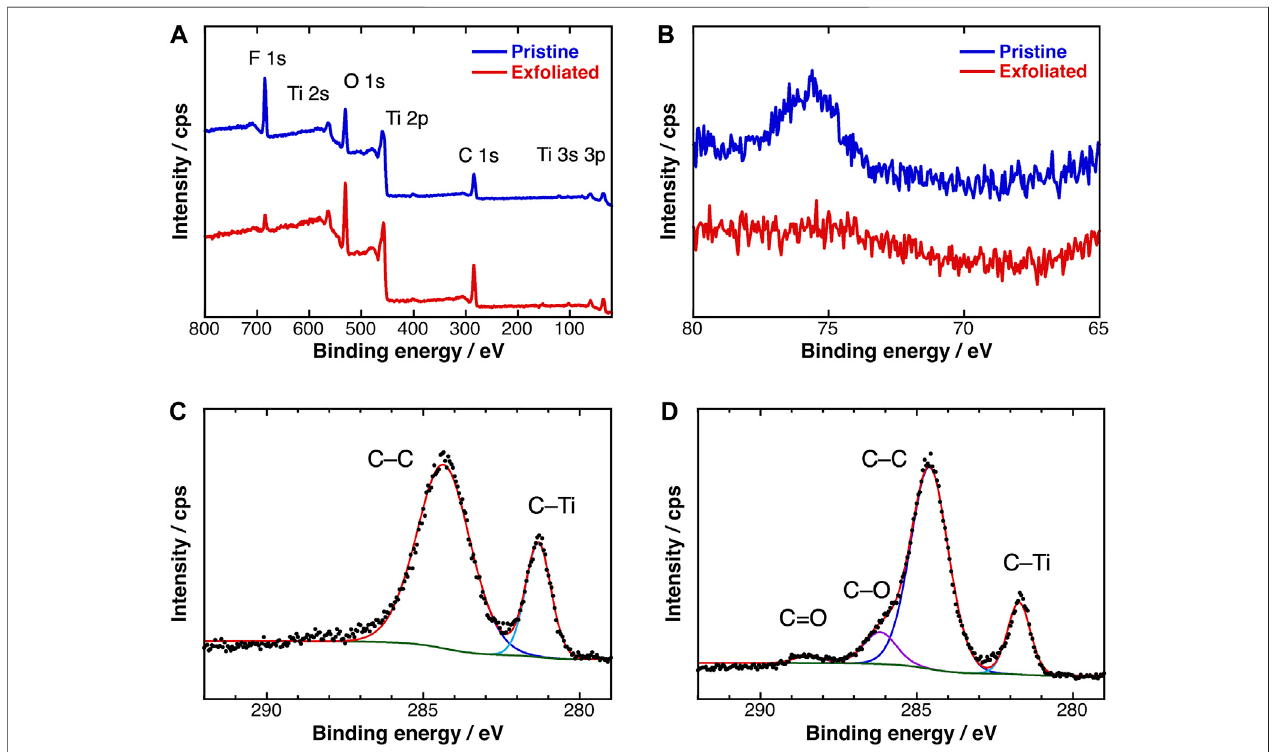
FIGURE 5 | (A) Survey and (B) Al 2p XPS spectra of (blue) pristine and (red) exfoliated Ti 3 C 2 T x MXene; C 1p XPS spectra of (C) pristine and (D) exfoliated Ti 3 C 2 T x MXene.